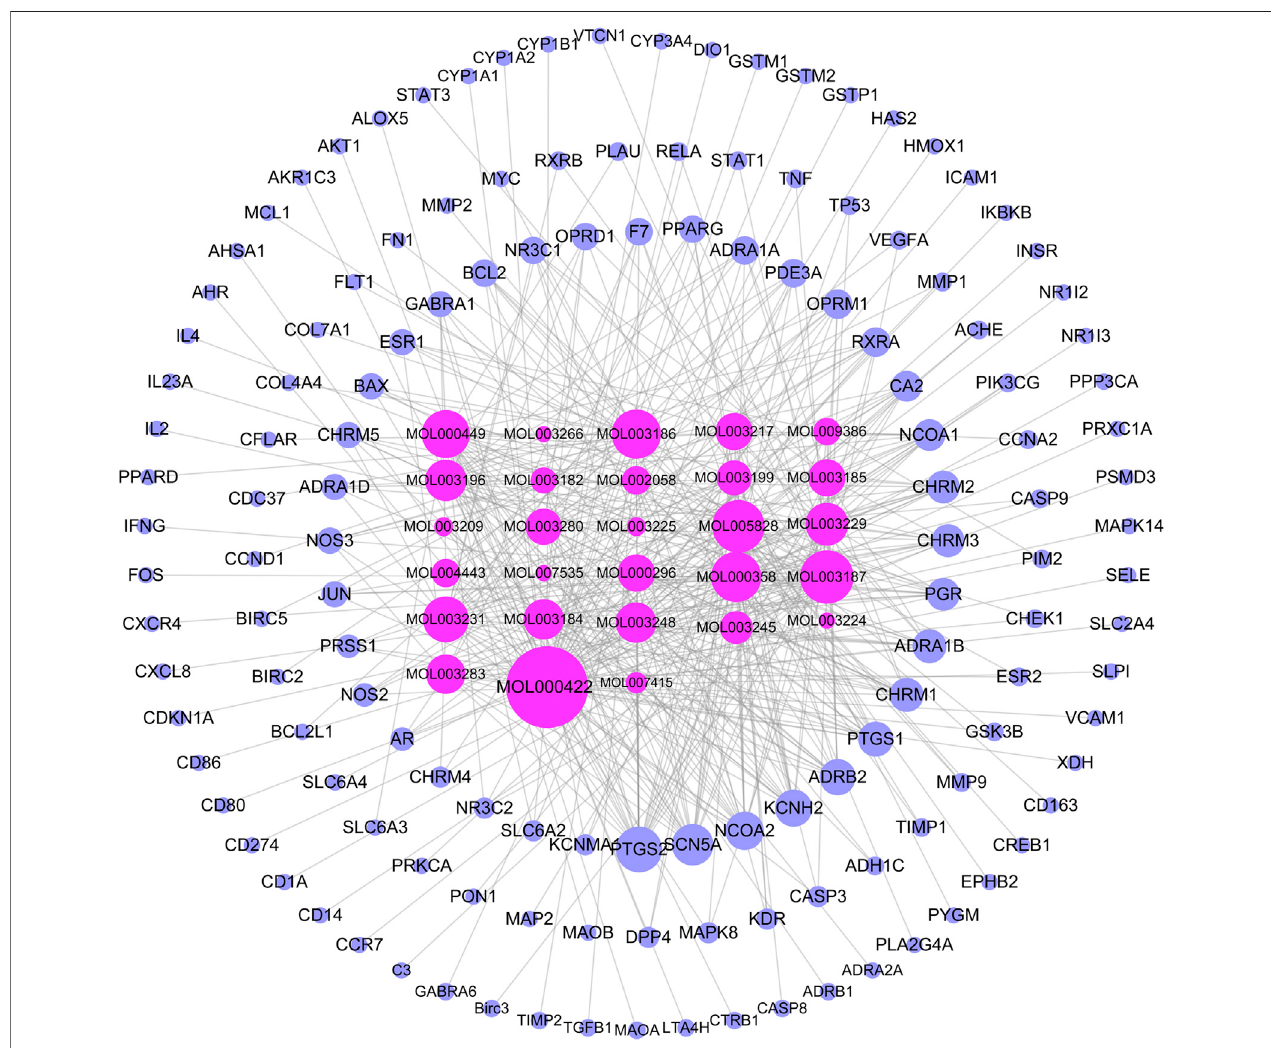
FIGURE 2 | TW- active ingredient-target diagram. The rose red inner circle is the compound (the compound without target is deleted), and the blue outer circle is the target. The larger the node, the greater the degree value, and the closer the prompt relationship.